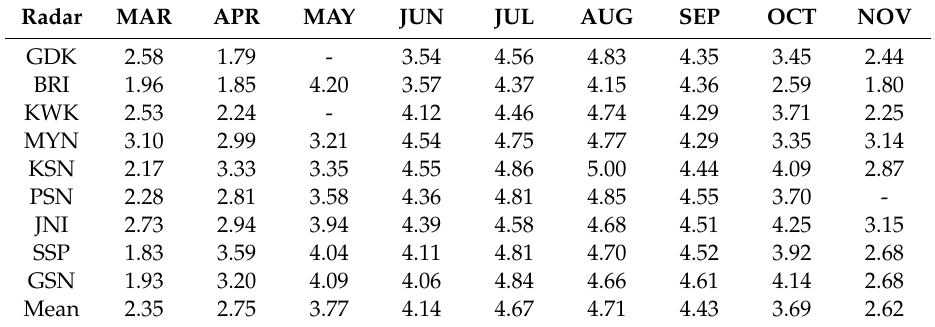
Figure 4. Monthly variation in mean height for BB PEAK identified using the Z H from March to November from the individual radar across the KMA weather radar network. The blue to red color indicates radar located from higher to lower latitudes. Table 3. Monthly mean height of BB PEAK at each radar sorted in ascending order according to